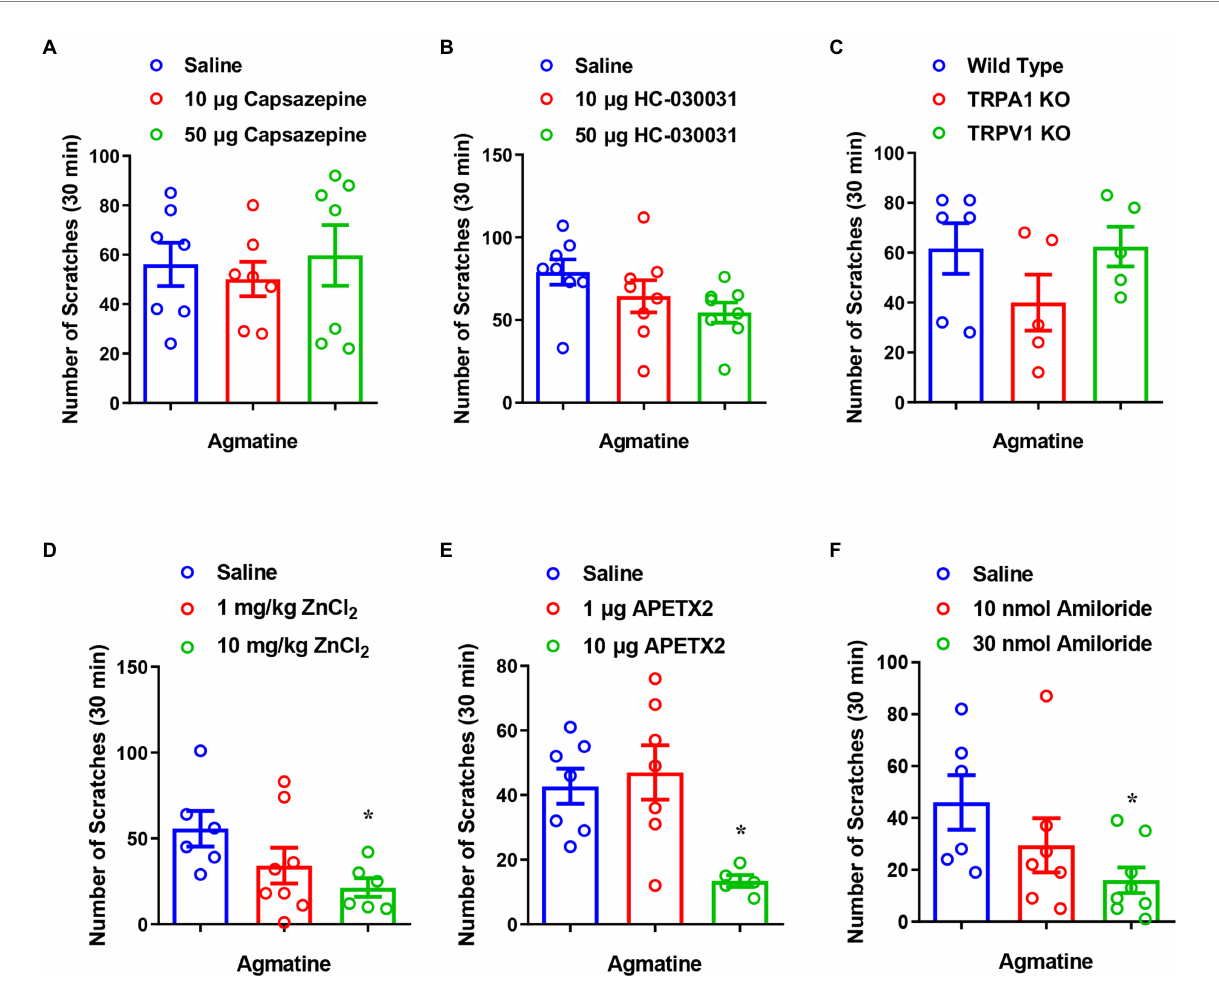
FIGURE 3 The inhibition of ASIC3, but not TRPA1 and TRPV1, reduced agmatine-induced itch. (A,B) The co-administration of agmatine (500 μ g) and the TRPV1 blocker capsazepine (10–50 μ g) or the TRPA1 blocker HC030031 (10–50 μ g) on agmatine-induced itch in mice ( p > 0.05 vs. agmatine, one-way AVOVA following Bonferroni’s test; n = 7–8 per group). (C) Agmatine-induced itch showed no obvious changes in TRPV1 − / − and TRPA1 − / − mice ( p > 0.05 vs. Wild Type, unpaired Student’s t test; n = 5–6 per group). (D–F) The effects of the ASIC3 blocker ZnCl 2 (1–10 mg/kg, i.p.) (D) , APETx2 (1–10 μ g, i.d.) (E) , and amiloride (10–30 nmol, i.d.) (F) on agmatine (500 μ g)-induced itch in mice (* p < 0.05 vs. Saline, unpaired Student’s t test; n = 6–7 per group). All data are expressed by means ±